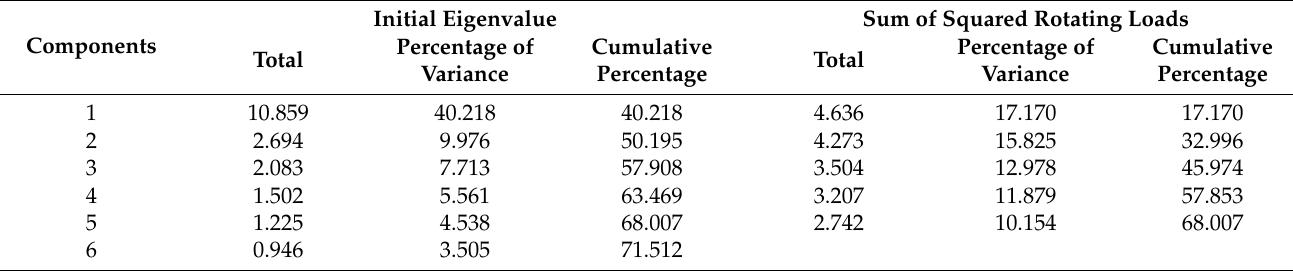
Table 2. Total variance of